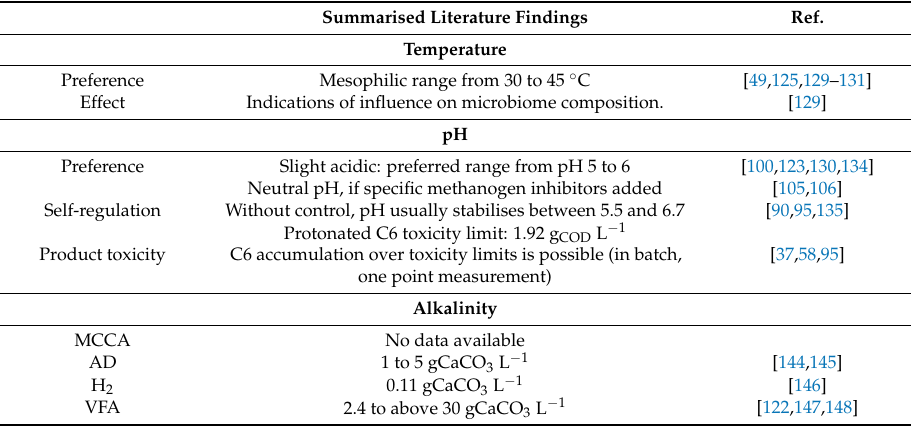
Table 4. Reported environmental conditions to select for chain elongation in MMC fermentation for MCCA